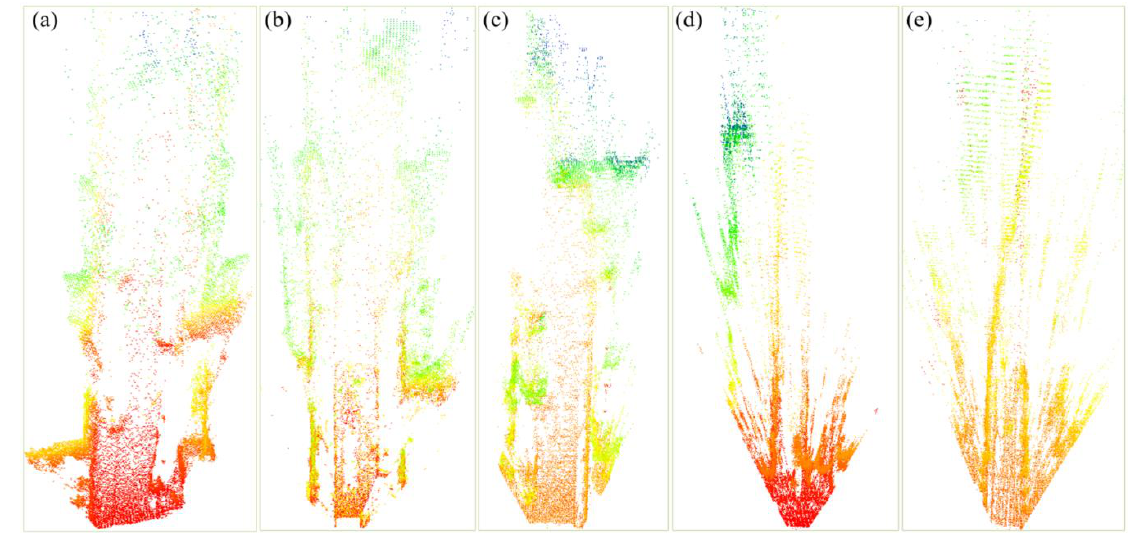
Figure 3. Visual point cloud frames generated by stereo matching. ( a ) The visual point cloud frame from sequence 00 of the KITTI dataset; ( b ) the visual point cloud frame from sequence 05 of KITTI dataset; ( c ) the visual point cloud frame from sequence 09 of KITTI dataset; ( d ) the visual point cloud frame from field test data Site-1; ( e ) the visual point cloud frame from field test data Site-2.